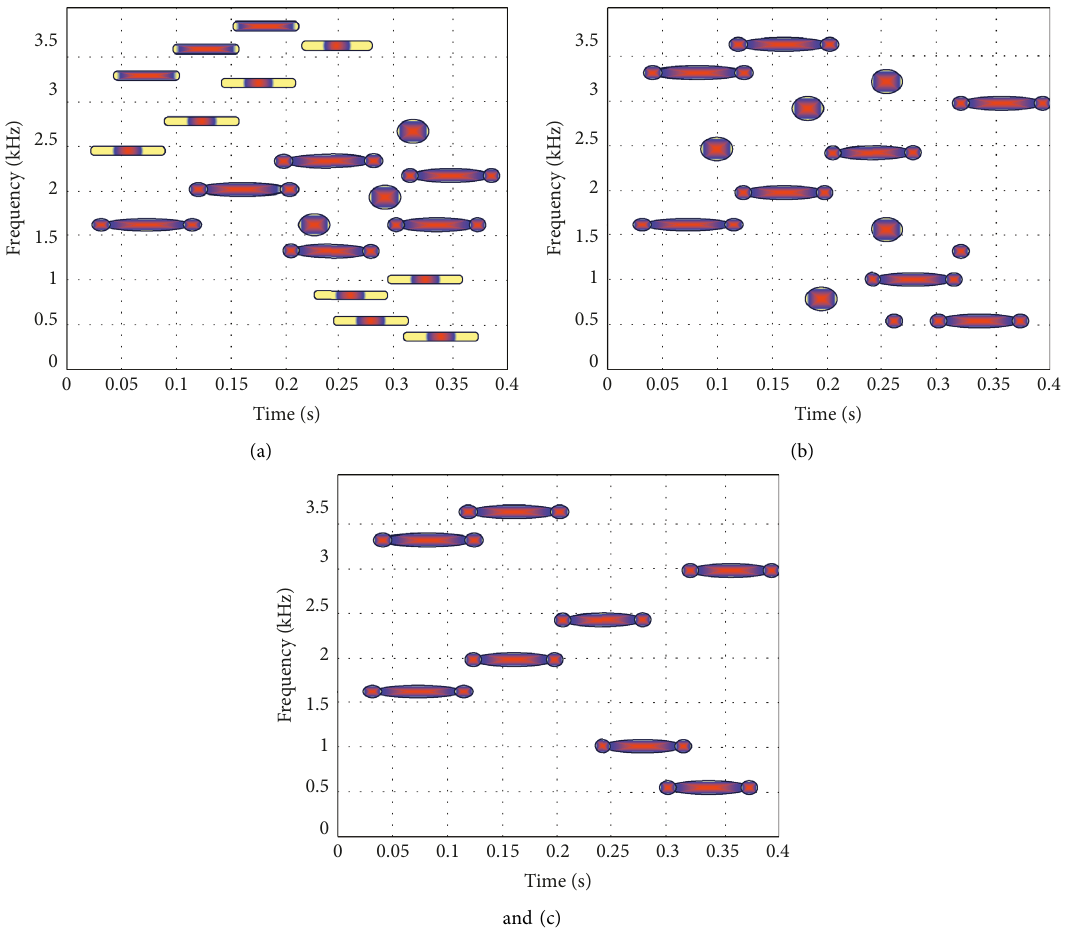
Figure 6: Time-frequency diagram of WVD and its improvement. (a) WVD, (b) PWVD, and (c)